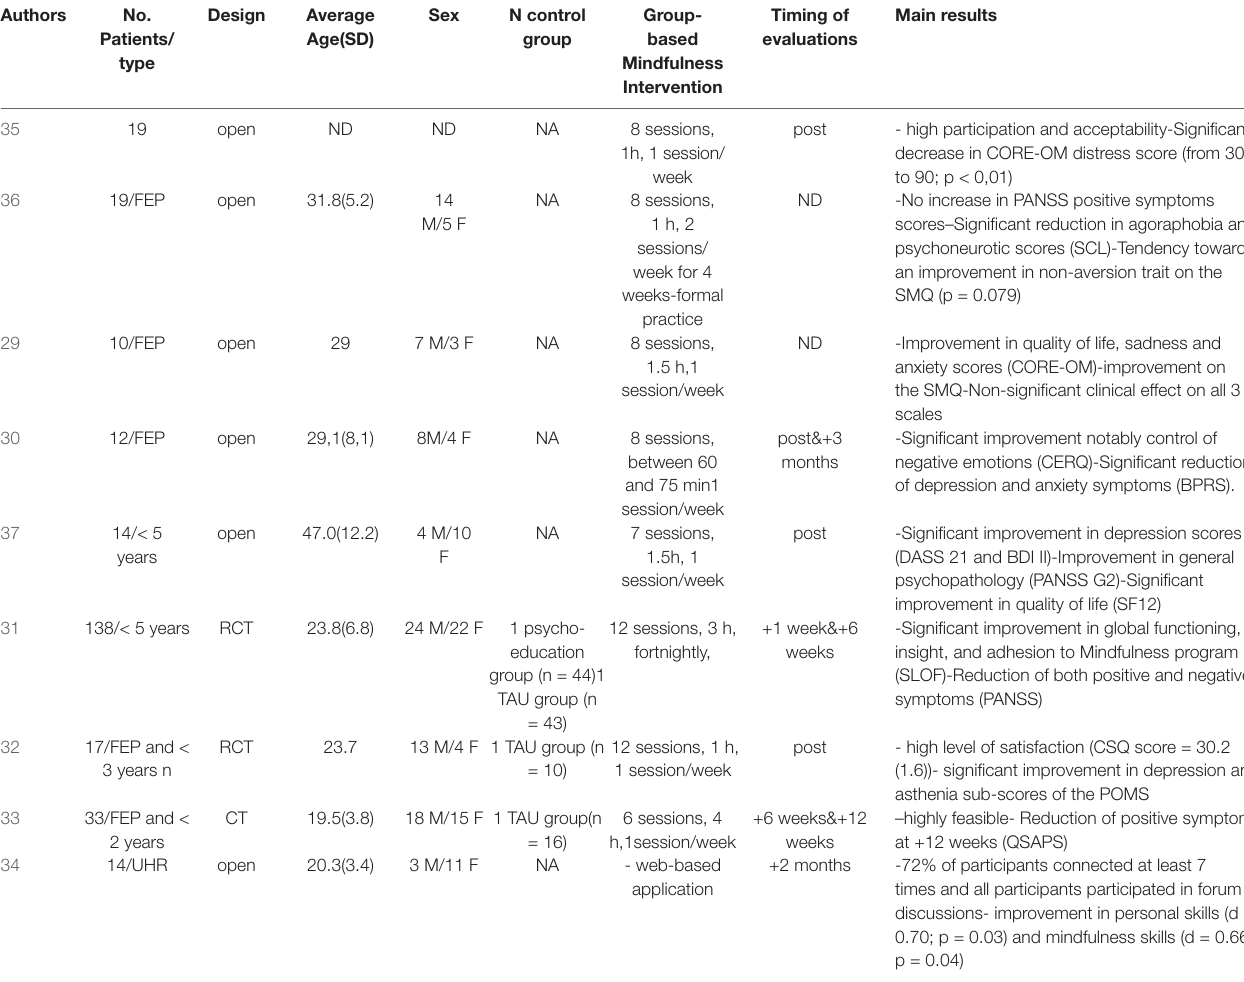
TABLE 1 | Main results from included studies investigating group-based mindfulness-based interventions in first psychotic episode and at risk for psychosis populations.